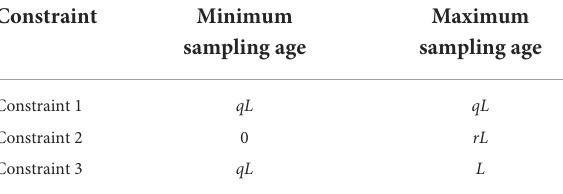
where 0 ≤ q ≤ r ≤ 1. Estimates of λ L and their 95% CI width were estimated from samples and averaged over the